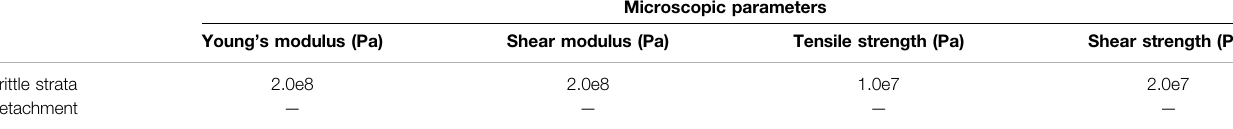
TABLE 3 | Interparticle bond properties of rock particles in the discrete element